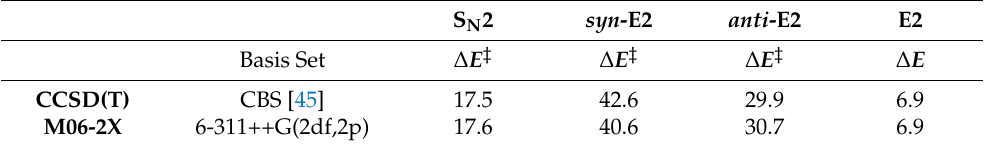
Table 1. Critical point energies (kcal mol −1 ) of the S N 2, and syn - and anti -E2 mechanisms. Energies were calculated with the M06-2X functional with the 6-311++G(2df,2p) basis set and reference CCSD(T)/CBS values obtained by Bento [45]. S N 2